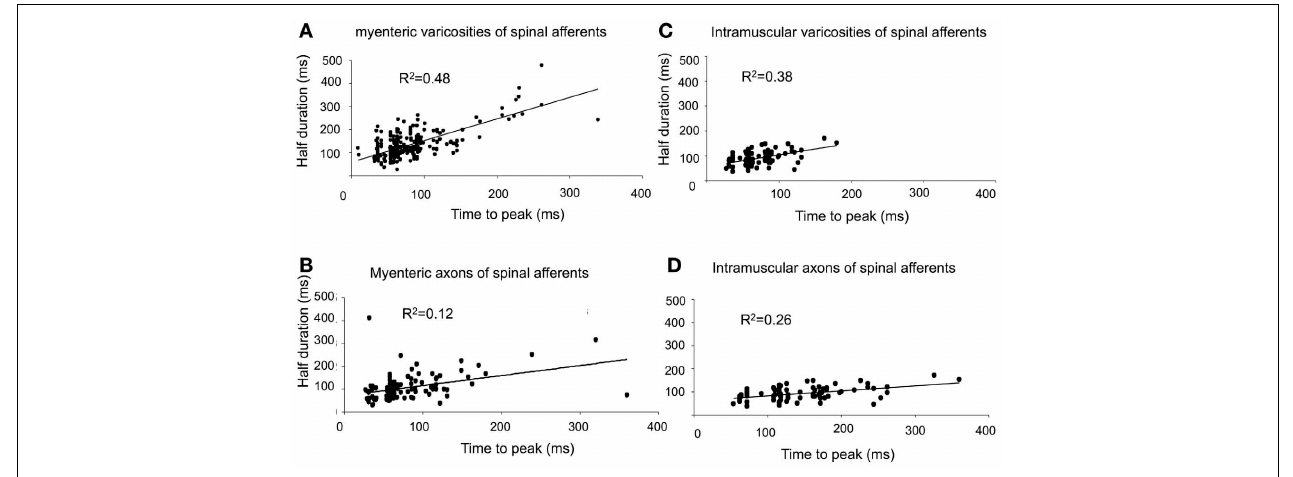
FIGURE 7 | Characteristics of calcium transients in varicosities and axons of spinal afferents. (A,B) Shows temporal characteristics of time-to-peak of calcium transients in myenteric varicosities (A) and axons (B) plotted against the half duration of individual calcium